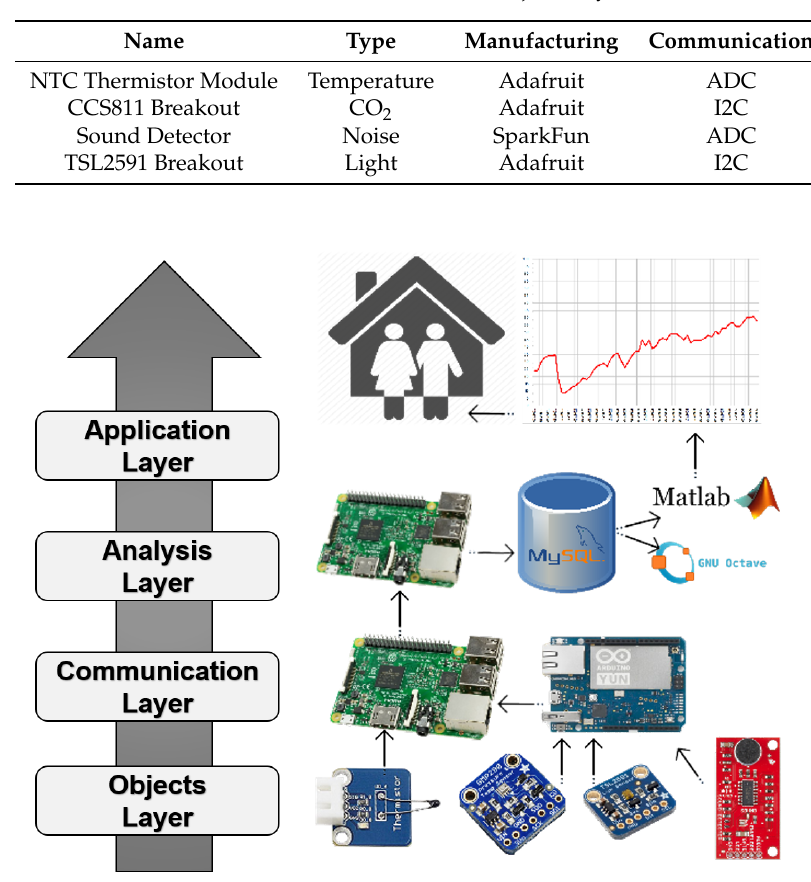
Figure 2. Data processing